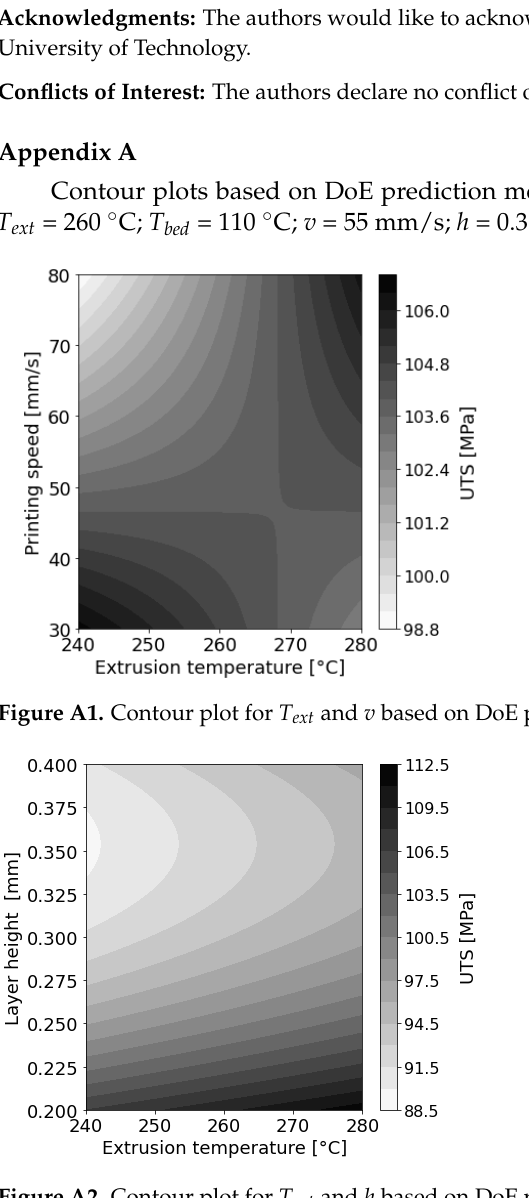
Figure A3. Contour plot for T ext and T bed based on DoE prediction model. Figure A4. Contour plot for T bed and v based on DoE prediction model.